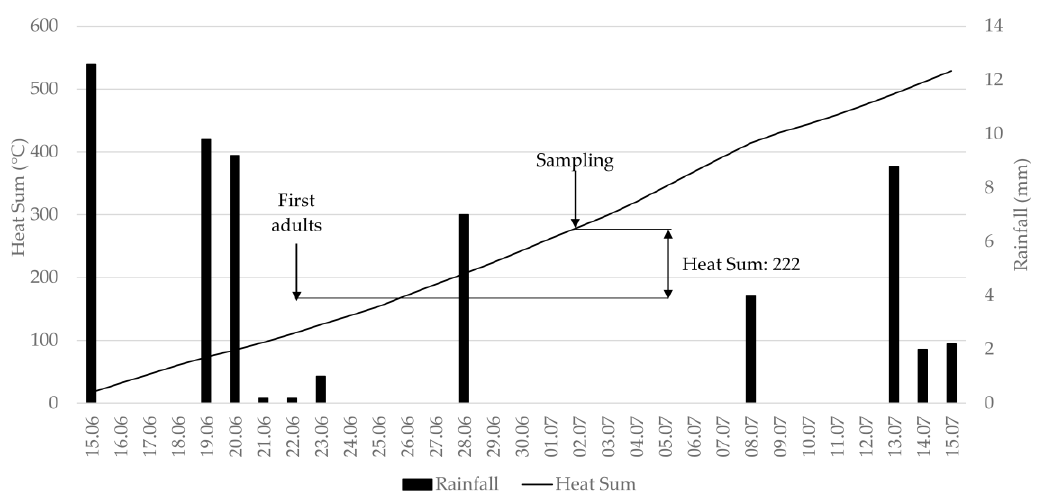
Figure 1. Cumulated effective temperature for the development of Thrips tabaci and precipitation recorded in 2015.